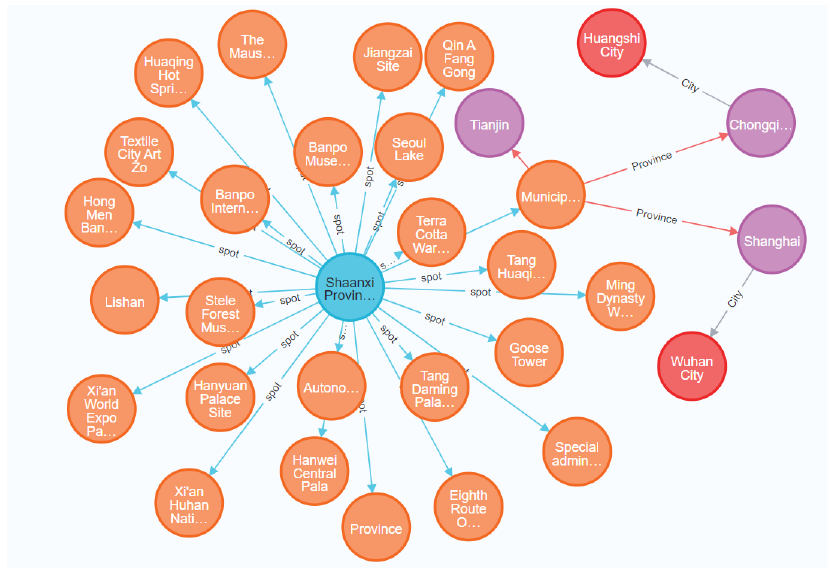
Figure 3. Shaanxi tourism knowledge graph as an